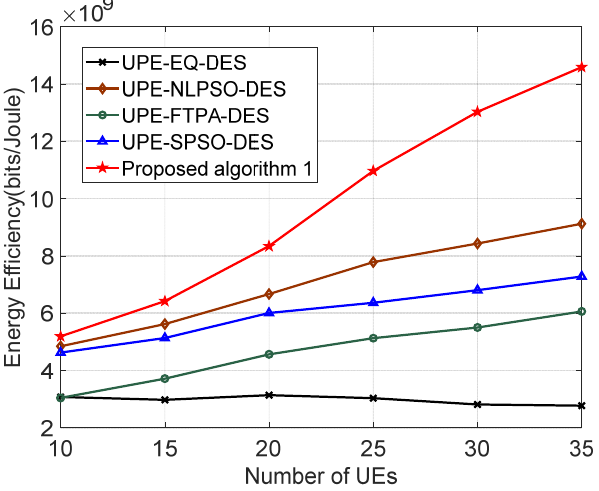
Figure 5. Energy efficiency versus the number of UEs for different joint algorithms.